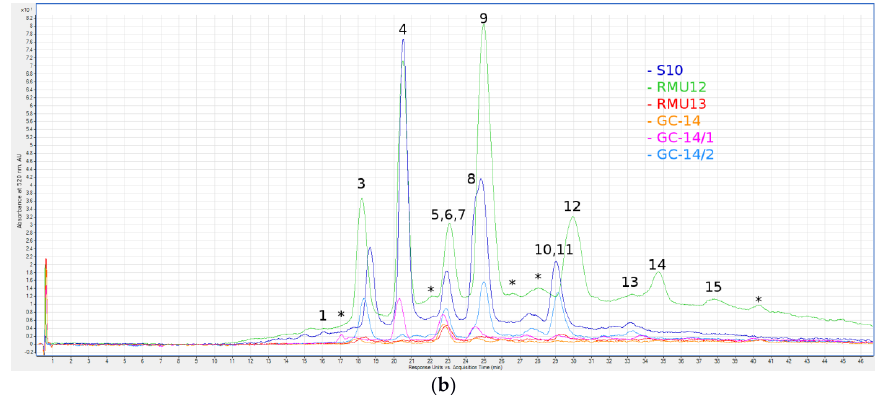
Figure 1. Liquid chromatography with spectrophotometric absorption detection in visible spectrum (LC-VIS) chromatograms at 520 ± 4 nm of green grain ( a ) and violet grain ( b ) seeds extracts. 1—